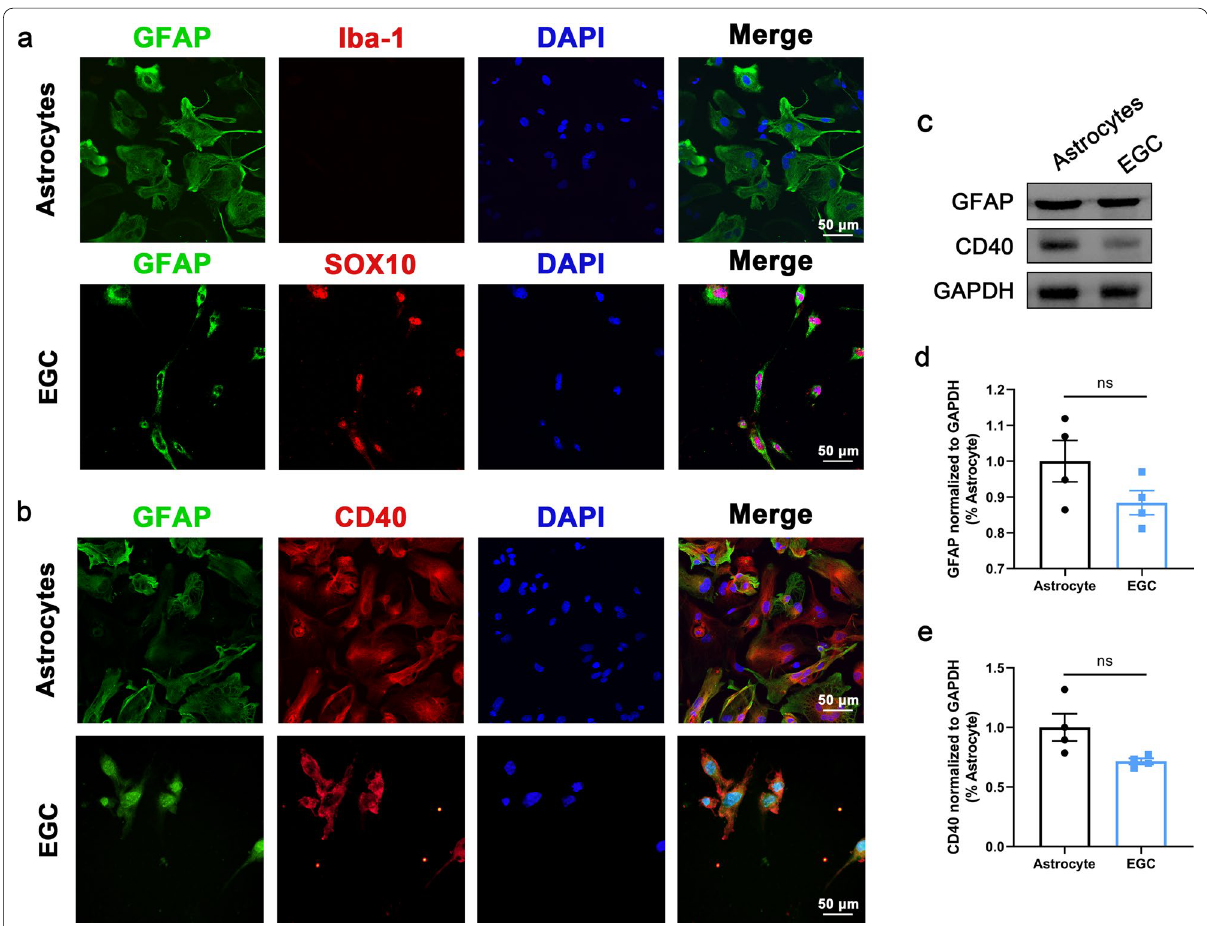
Fig. 3 Localization of CD40 in EGCs. a The purity of primary EGCs and astrocytes cultures was > 95% as determined by immunofluorescence. b GFAP and CD40 immunofluorescence was detected in primary EGCs and astrocytes. c – e Western blot analysis showed that CD40 was expressed in primary EGCs as in